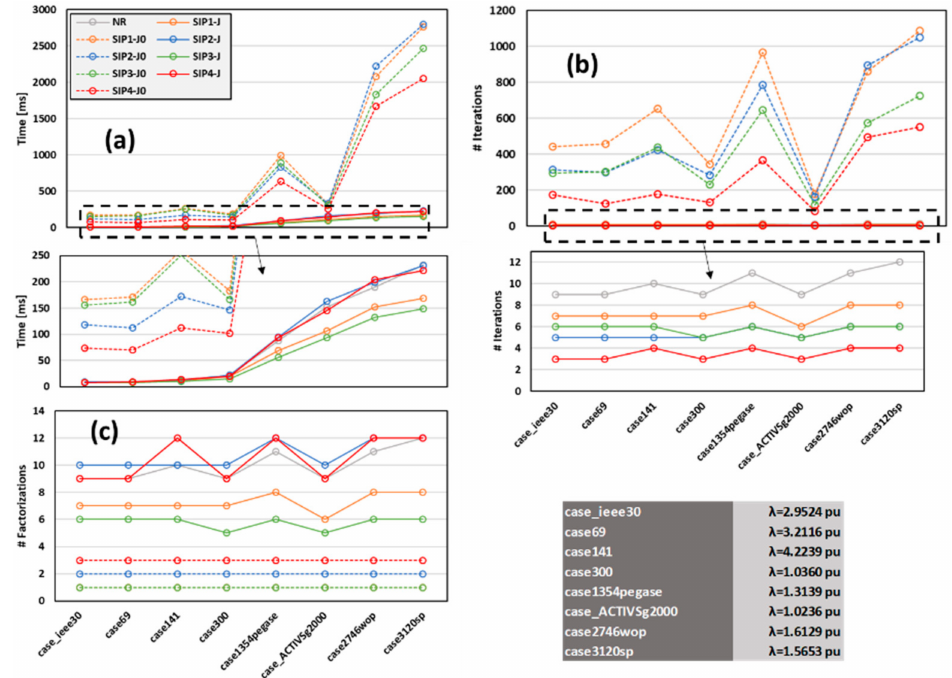
Figure 5. Comparison of the results obtained in well-conditioned systems in a limit load scenario. ( a ) Execution time (ms), ( b ) total iterations number and ( c ) total